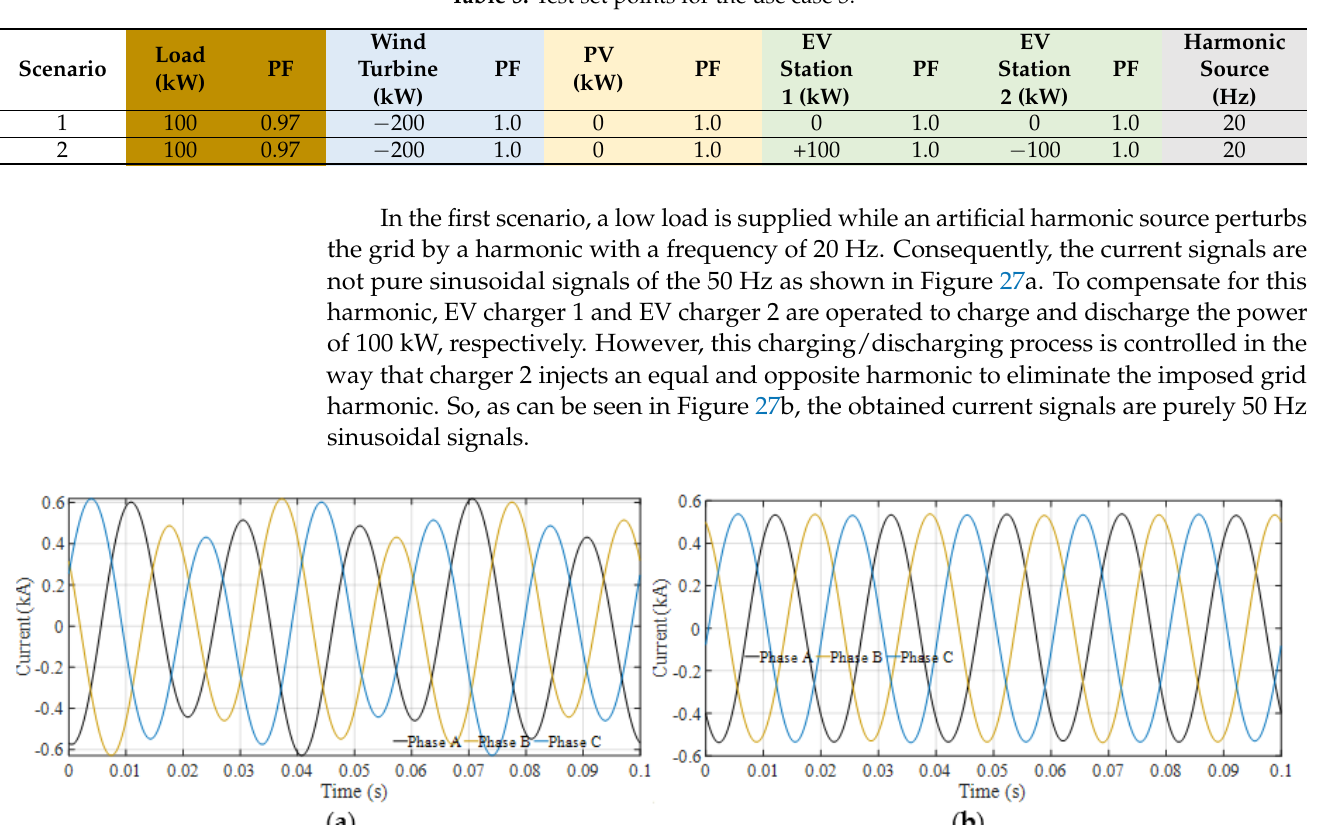
Table 5. Test set points for the use case 3.